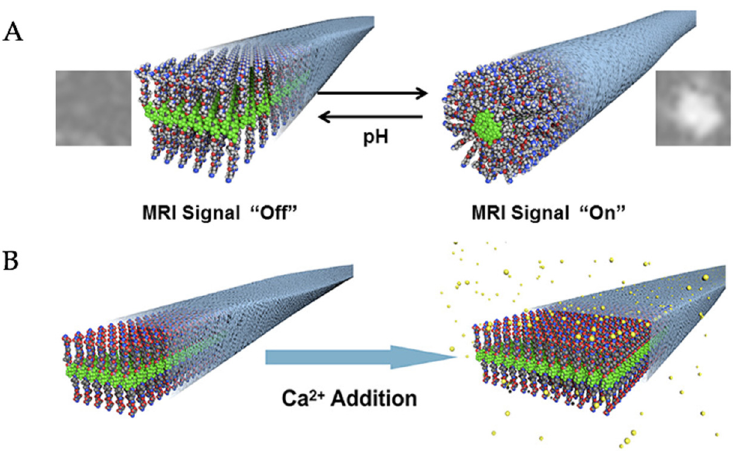
Figure 16. Highly fluorinated peptide amphiphiles that demonstrate changes in morphology and 19F-NMR signal intensity in response to ( A ) pH and ( B ) Ca 2+ concentration. Figures adapted with permission from [103,104]. Copyright 2017 American Chemical Society.